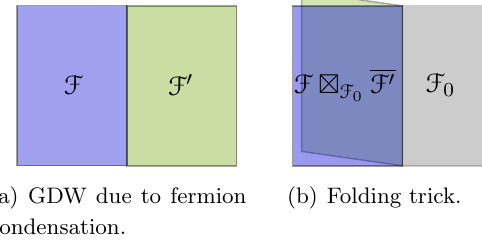
Figure 5 . (a) Two fTOs F and F ′ connected by a GDW via condensing some fermions in F .